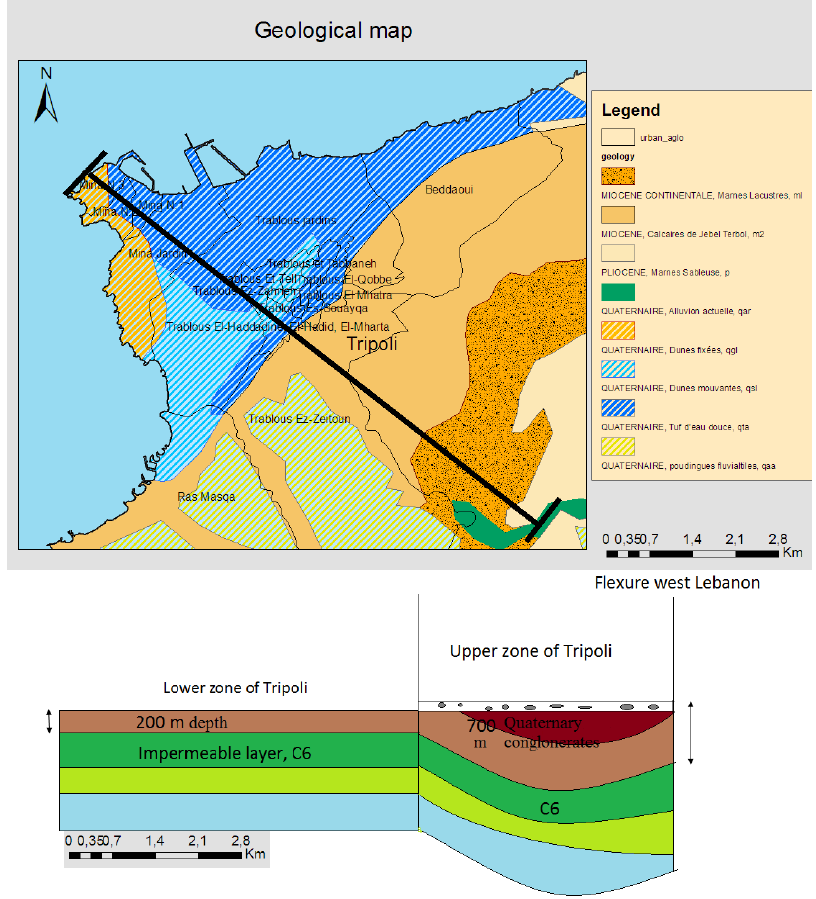
Figure 2. Geological map and stratigraphy of Tripoli, after Kalaoun et al. (2016) [12].